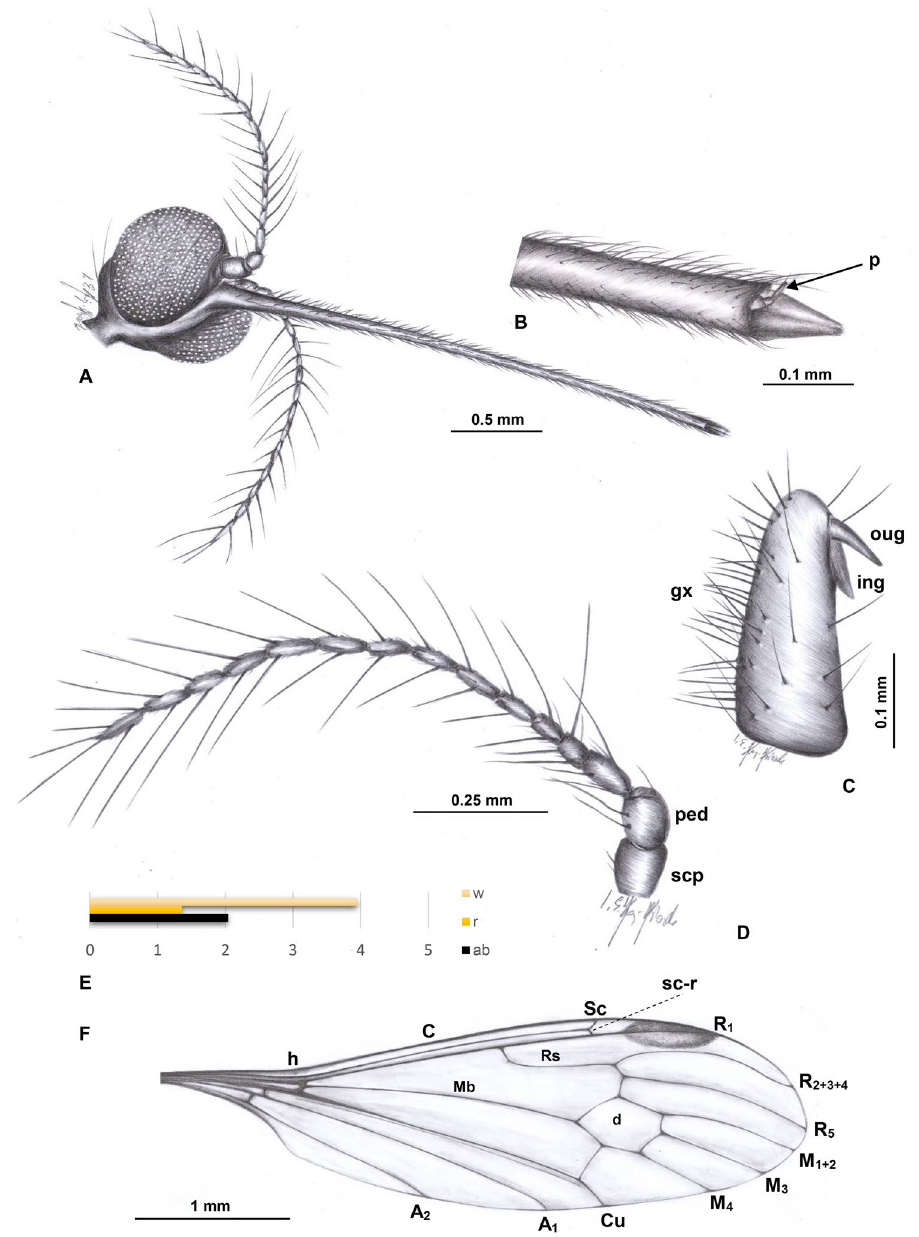
Figure 5. Elephantomyia ( Hoffeinsonia ) prima sp. nov. No. CCHH 874–1 (male), coll. Ch. & H. W. Hoffeins, holotype, drawings: ( A ) head, latero-ventral view; ( B ) enlarged view of apical part of rostrum; ( C ) gonocoxite and gonostyles; ( D ) antenna; ( E ) the diagram illustrating the relationship between the length of wing (w), rostrum (r) and abdomen (ab); ( F ) wing. Abbreviation: a—antenna; ped—pedicel; scp—scape; I–IV— palpomeres I–IV; gx—gonocoxite; oug—outer gonostylus; ing—inner gonostylus;